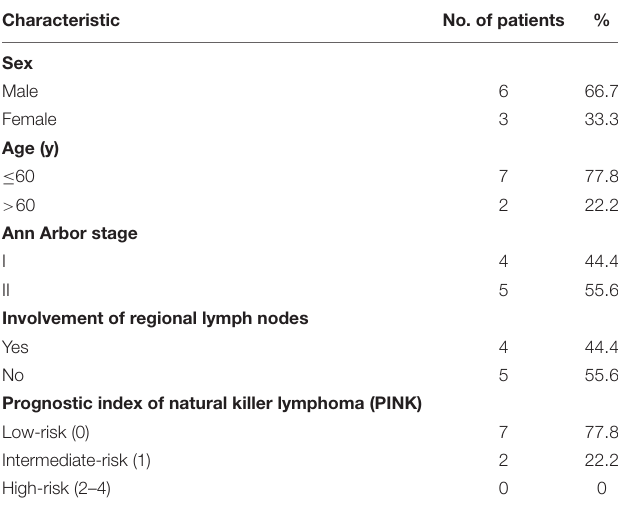
TABLE 2 | Clinical characteristics of the patients in Cohort B ( n =